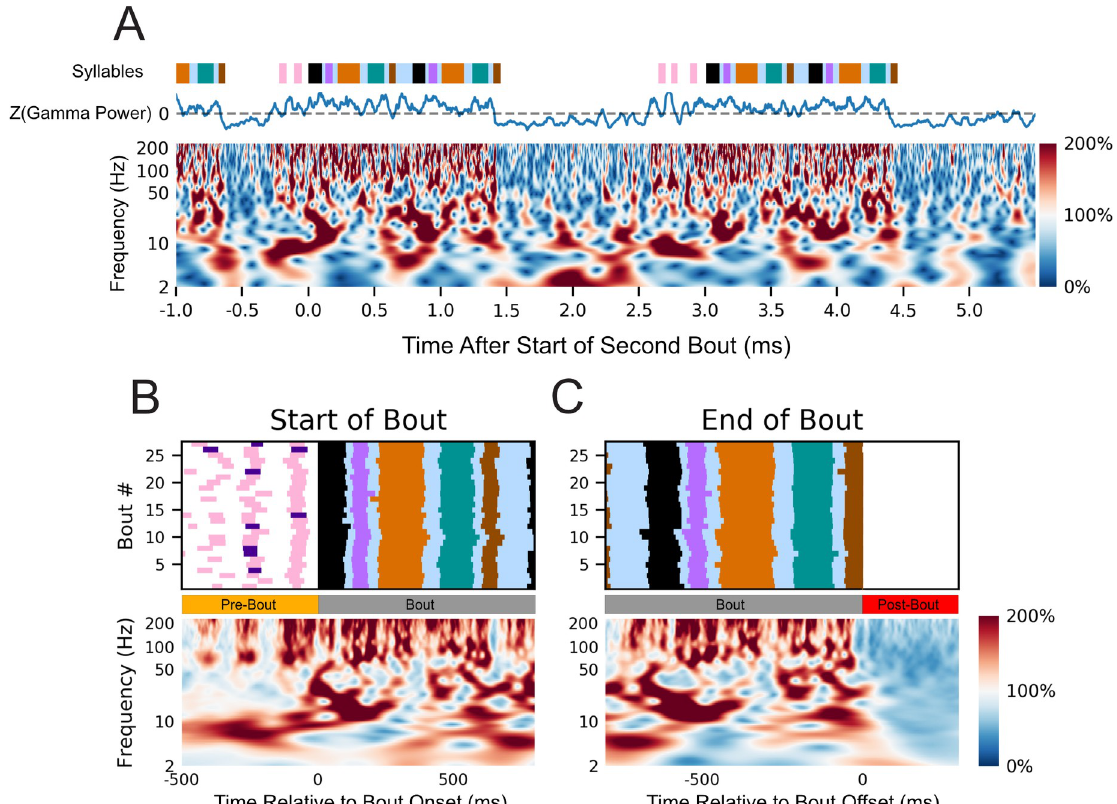
Fig 4. Variation in HVC LFP power correlate with vocal behavior. (A) Normalized spectrogram (bottom) of LFP activity from one representative channel (see Methods) aligned to the free vocal performance of a male zebra finch (z007) during the production of three separate bouts. Each frequency is scaled to its percentage of the mean amplitude during the respective VAP. Above the spectrogram is the z- scored power of the 50–200 Hz band smoothed with a 50ms rolling mean window aligned to the same behaviors. Colored bars above the spectrum annotate the vocal behavior, with color representing a distinct syllable with the same color-coding as Fig 2 . (B) Normalized spectrogram (bottom) from the same representative channel as (A) averaged across multiple renditions of similar bouts (n = 27, top) aligned to the start of the first motif in the bout. (C) As in (B) but aligned to the end of the last motif in the bout. Above each is a behavioral raster showing the time course of the behavior being averaged (n = 27 bouts). No dynamic-time warping was used, and all motifs were from the highest yield day for the subject. To ensure the start and end of the bout are unique time periods, only bouts with more than one motif in duration were used. Behaviorally inconsistent bouts were excluded for clarity of visualization; including them does not qualitatively alter the